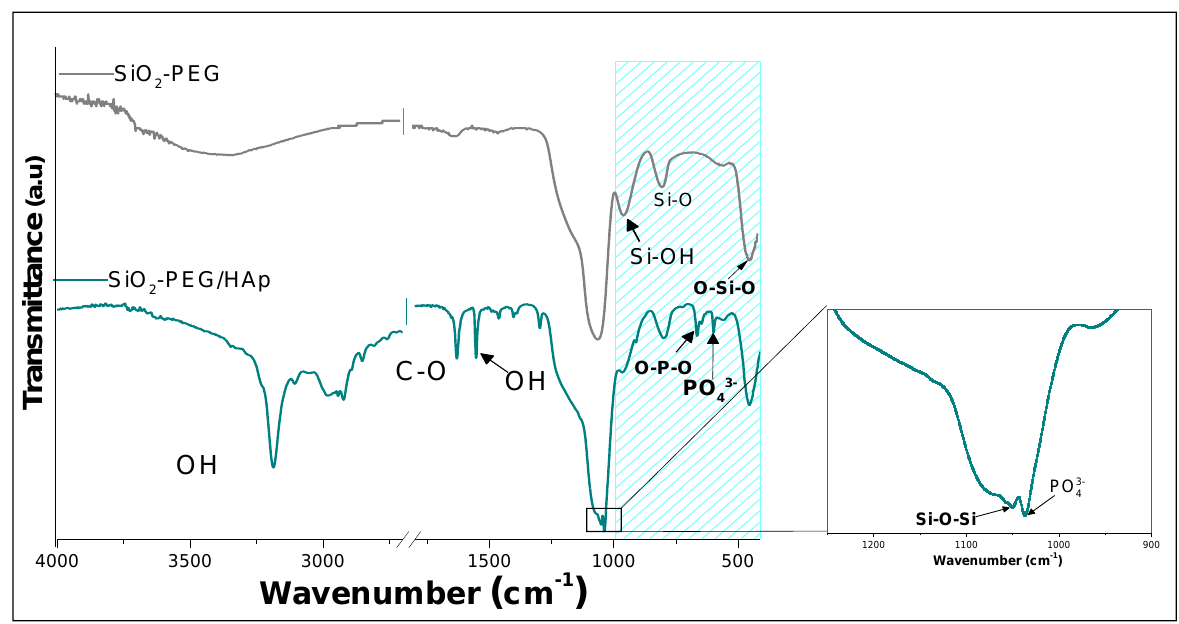
Figure 4. FTIR-ATR spectrum of SiO 2 -PEG before and after the biomimetic growth of hydroxyapatite. Diffractograms of SiO 2 -PEG and SiO 2 -PEG/HAp samples (Figure 5) showed a charac- teristic broad peak corresponding to amorphous phase of SiO 2 , which was obtained around 22 ◦ . After biomimetic growth (SiO 2 -PEG/HAp sample), small fine peaks were observed, in addition to the broad peak attributed to SiO 2 . The SiO 2 -PEG/HAp sample presented the characteristic diffraction peaks of hydroxyapatite (diffraction pattern PDF # 40-0008). Also, the characteristic diffraction peak of carbonated hydroxyapatite, according to the diffraction pattern PDF # 19-0272, at 31.83 ◦ with diffraction plane (1,1,2), is observed. This same peak also corresponds to hydroxyapatite.